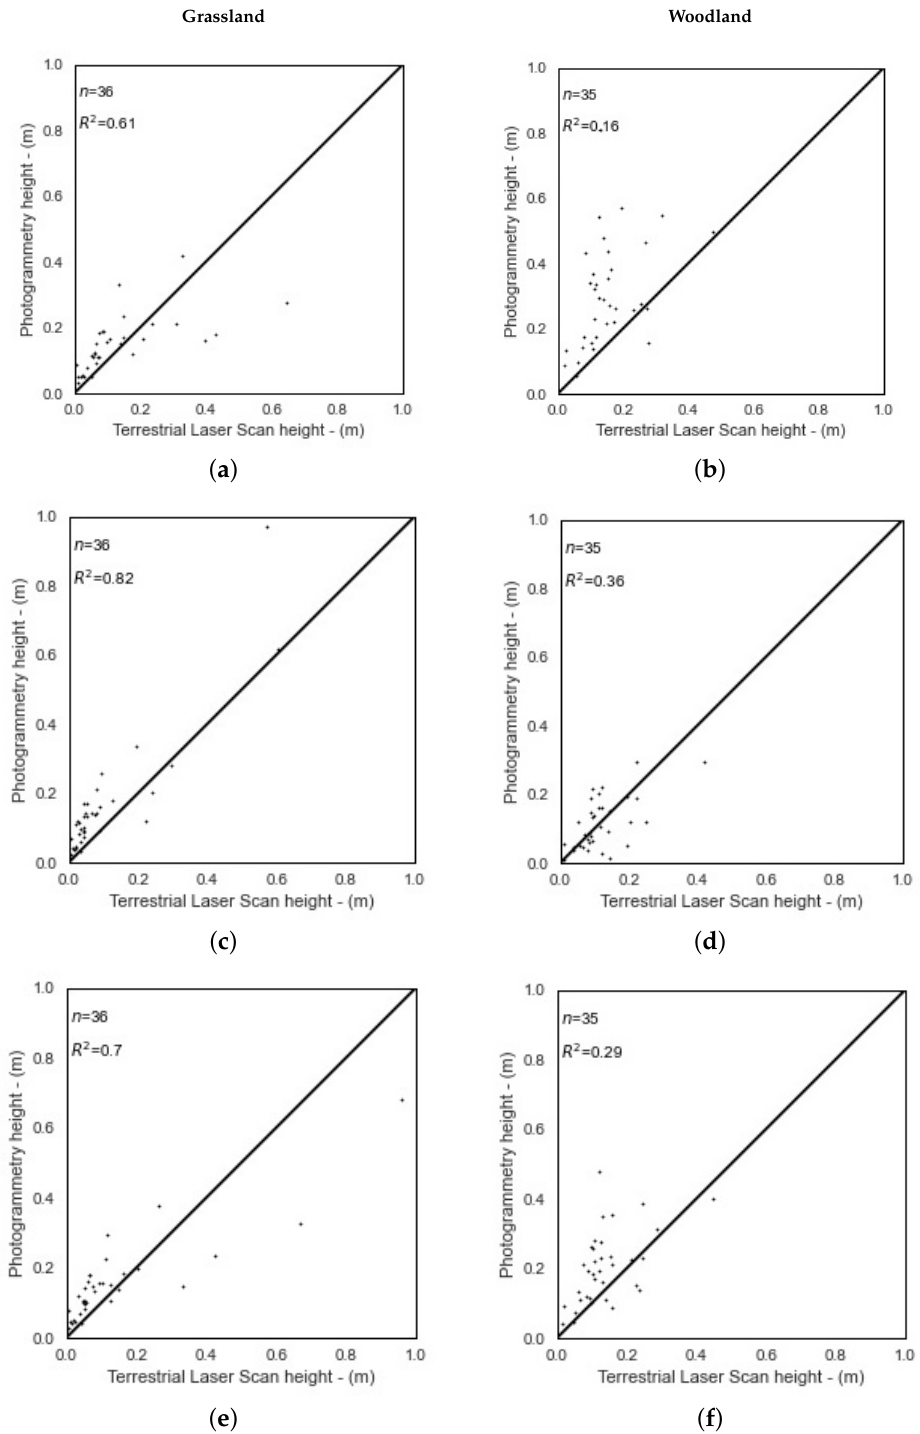
Figure 5. Least squares linear relationship between terrestrial laser scanner measured height and RPAS photogrammetric estimated height for the grassland and woodland communities. Average maximum quadrat height ( a , b ), average minimum quadrat height ( c , d ) and average mean quadrat height ( e , f ).